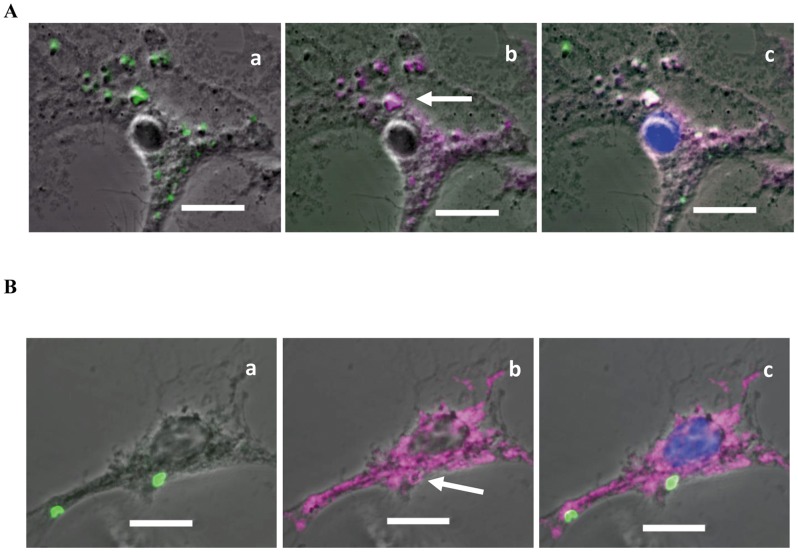
The interaction of S. Typhimurium with ESDCs was followed by fluorescent labeling.Confocal microscope images of ESDCs (phase contrast) infected with S. Typhimurium SL1344(p1C/1) expressing GFP, (A) co-labeled with early endosome marker EEA-1 at 30 minutes post-infection, (B) late lysosome marker LAMP-1 at 3 hours post-infection. Images are subdivided into (a) bacteria alone (FITC), (b) endosome compartment alone (APC-Cy7), with labeling arrowed. (c) Combined channels with DAPI added. Scale bar 10 µm.